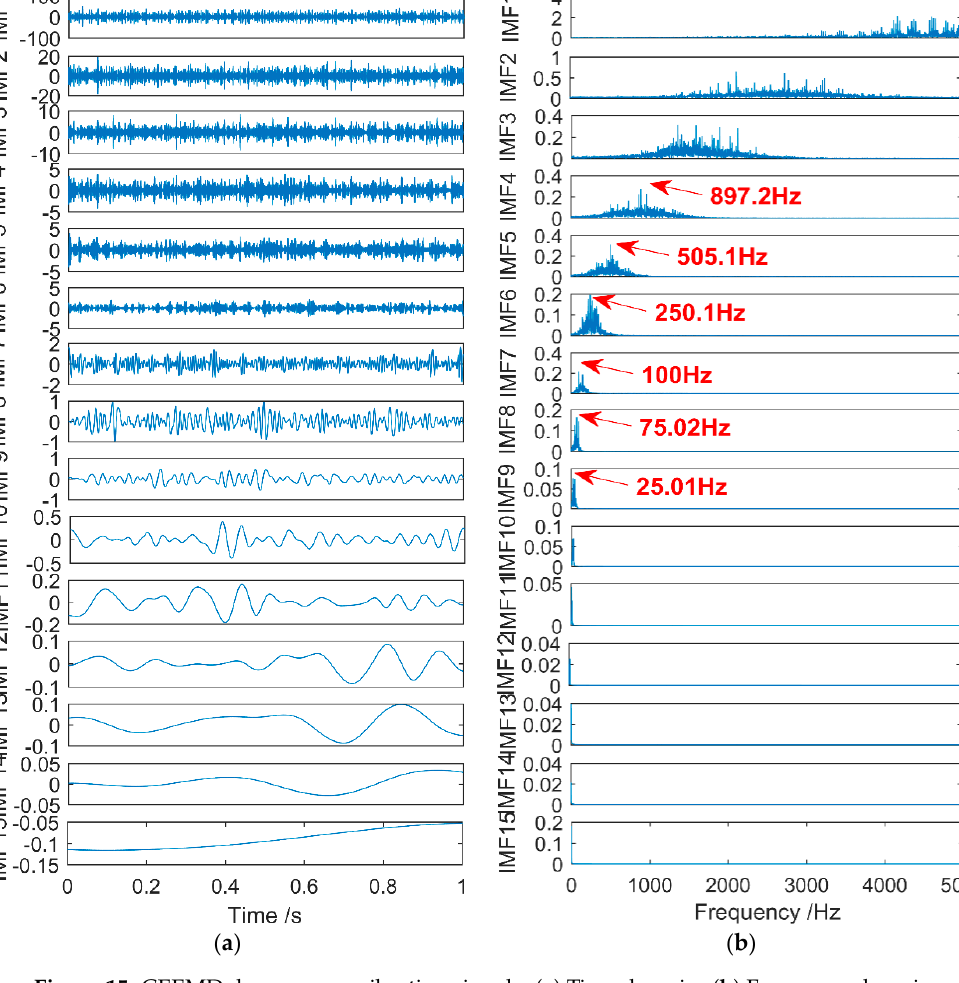
Figure 16. MSE value of 10,000 sets of random noise signals (the signal length is consistent with the vibration signal).